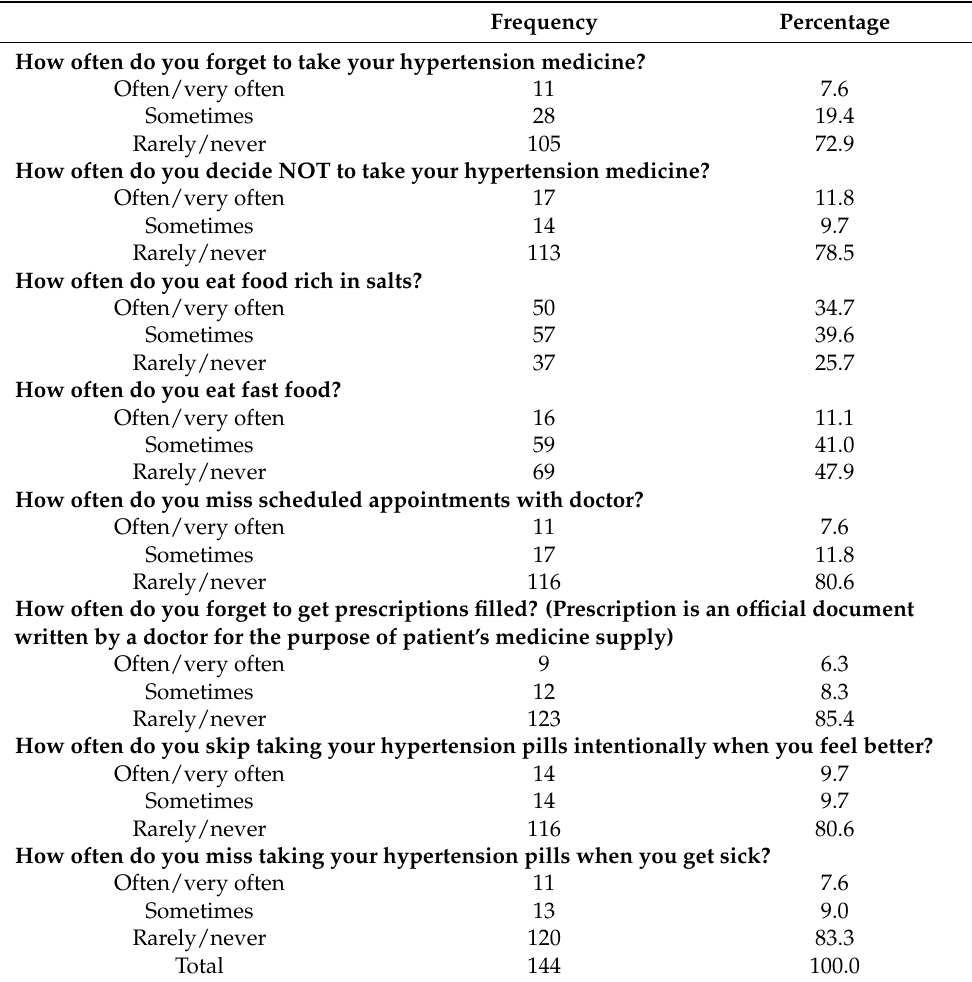
Table 3. Overall responses to adherence